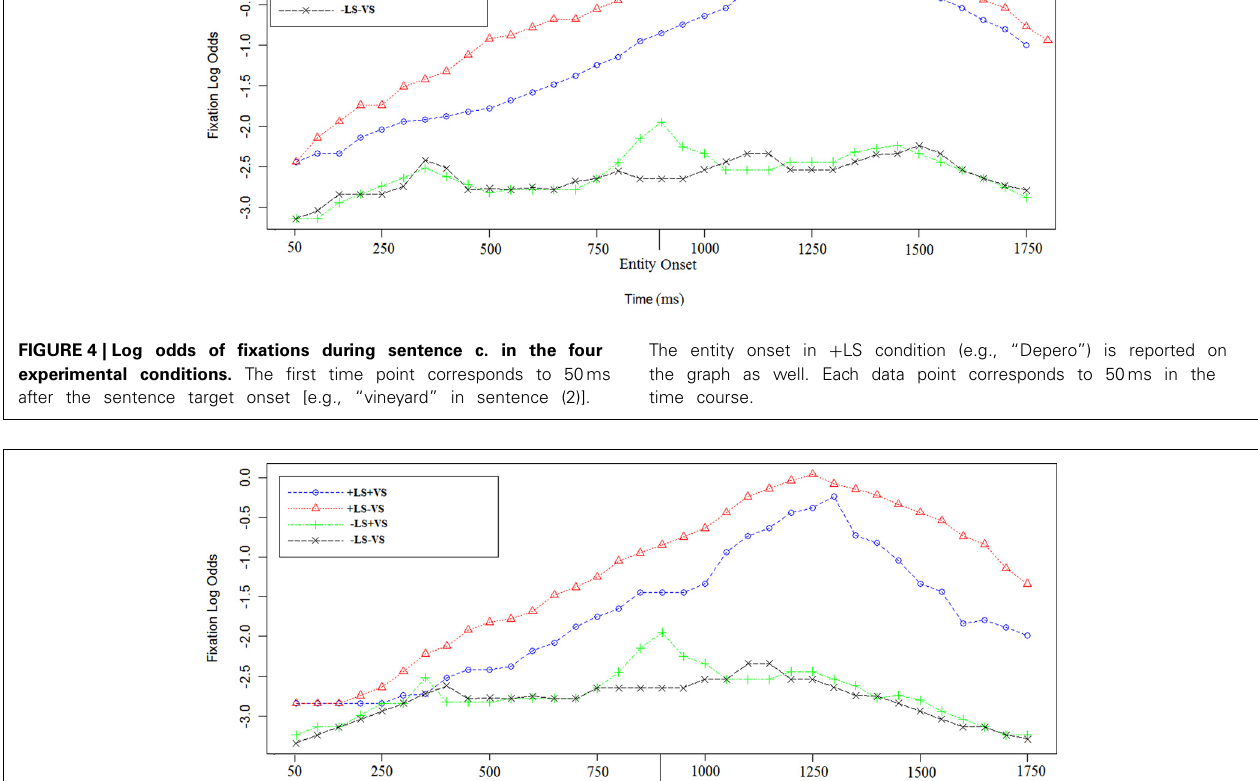
FIGURE 5 | Log odds of fixations during sentence d. in the four experimental conditions. The first time point corresponds to 50ms after the sentence target onset [e.g., “house” in sentence (2)]. The